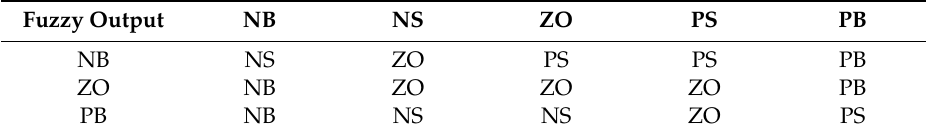
Table 5. Fuzzy control rule.